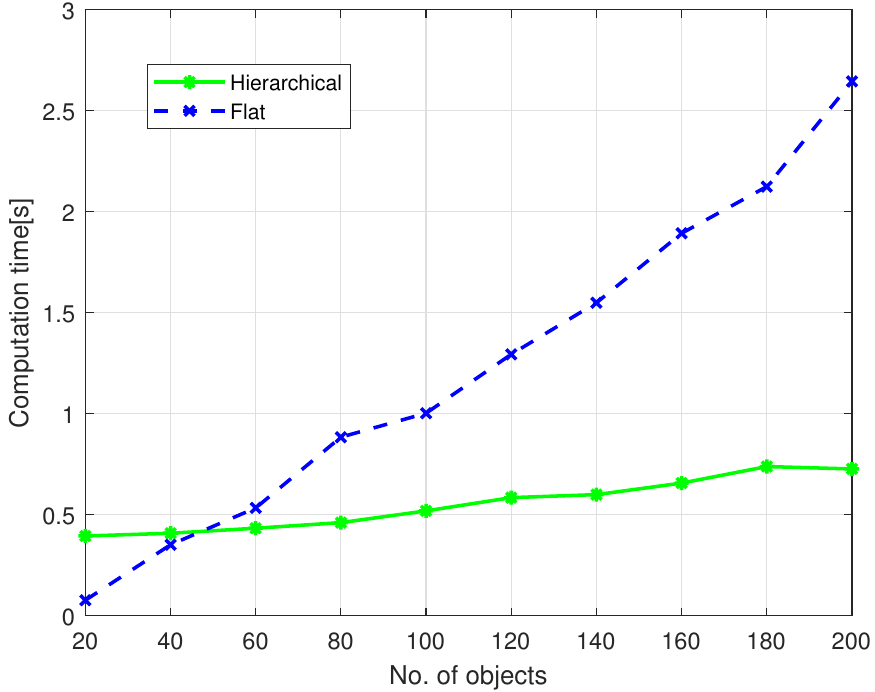
Figure 7. Computational time comparison between baseline flat CNP and proposed hierarchical task planning framework for a single task planning. There are 20 satellites with 5 clusters. The objects are decomposed into 12 clusters.